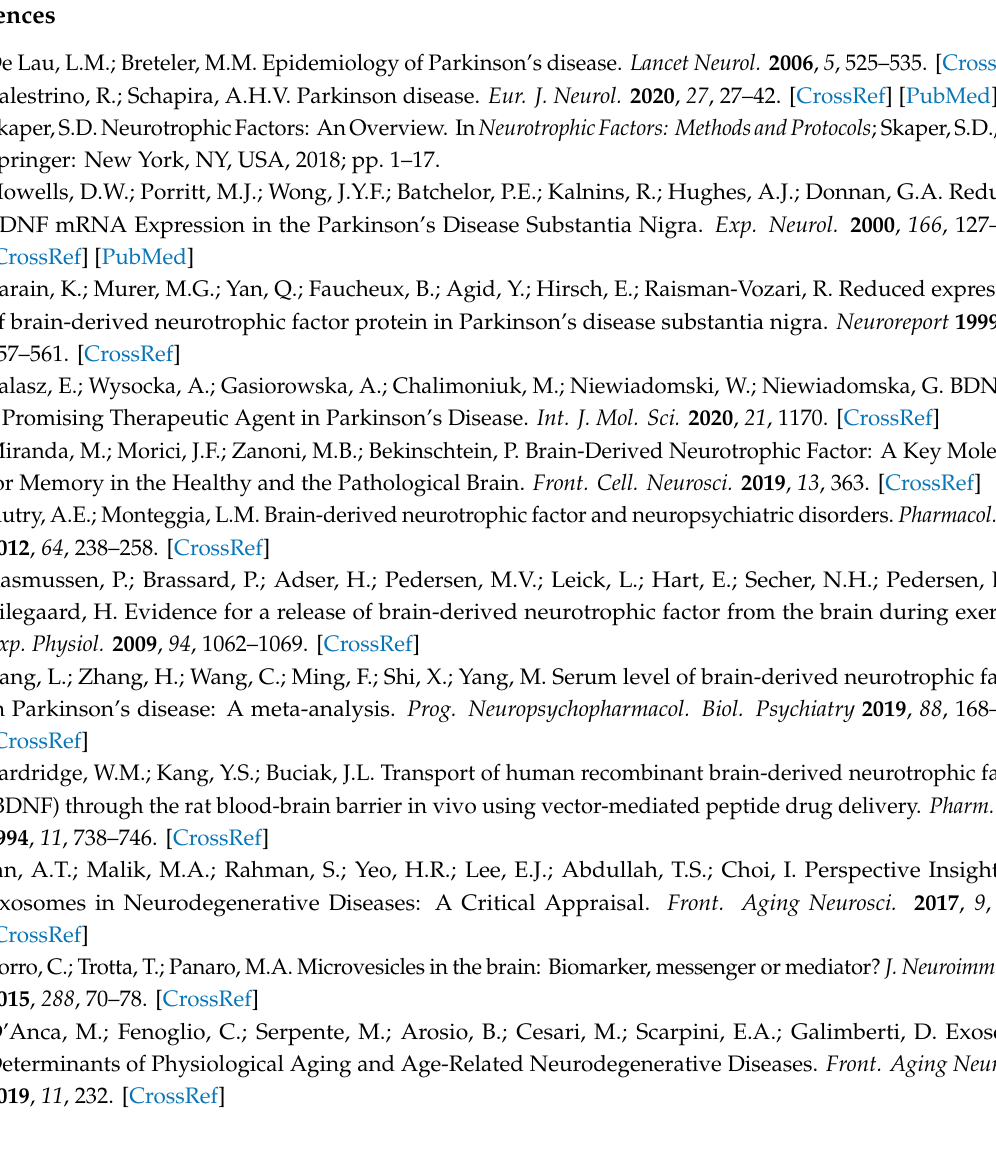
Table S1: The comparison of scores in subitem of UPDRS part III between PD patients with low to high EV BDNF